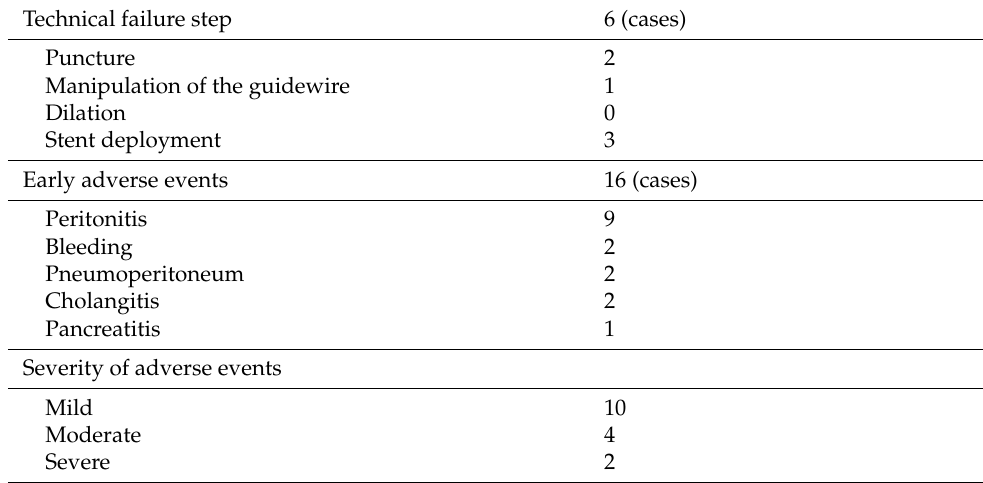
Table 4. Details of technical failure and early adverse